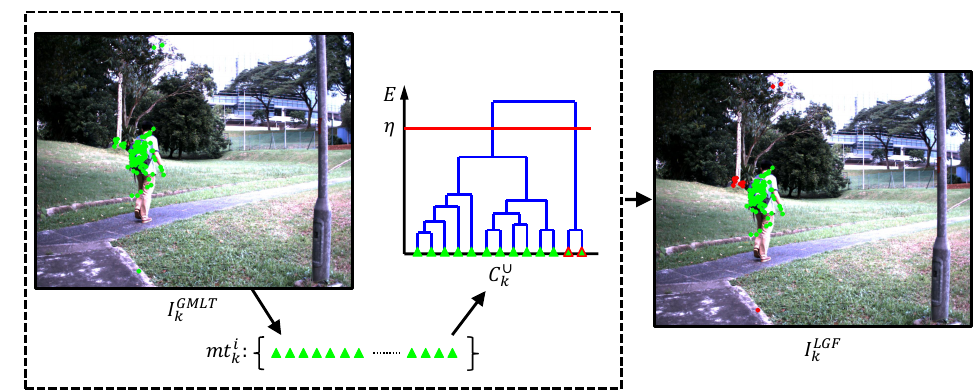
Figure 2. Illustration of the local geometric filter (LGF) module. The green points on the I GMLT matched and tracked FAST features from the GMLT module, i.e., F 1 . The green triangles are the FAST feature correspondences, i.e., C ∪ . The LGF module is utilized to filter outlier correspondences, as the k green triangles with red edges shown in the dendrogram. The red points on the I LGF filtered by the LGF